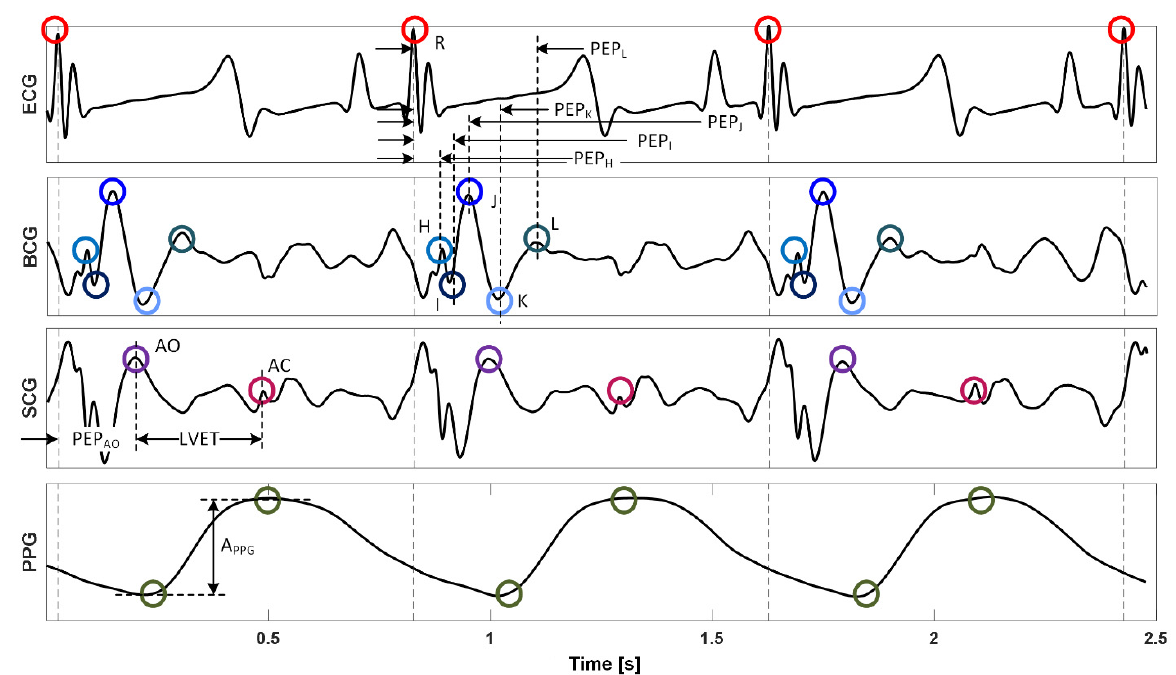
Figure 2. Representative physiological signal waveforms, fiducial points, and features. R: ECG R wave. H, I, J, K, and L: BCG H, I, J, K, and L waves. AO and AC: SCG AO and AC points.